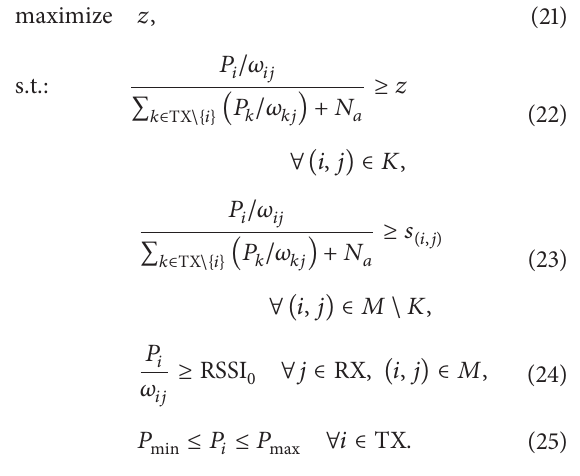
Algorithm 1, once Algorithm 2 has reached 𝜖 = 0